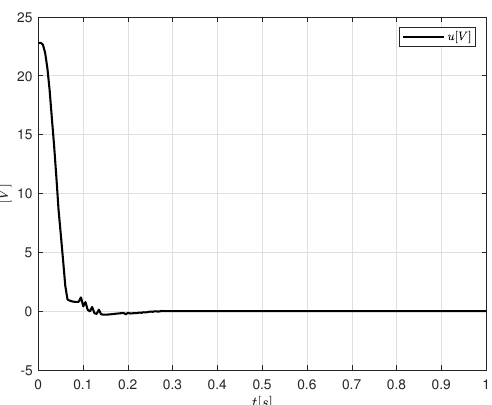
Figure 10. Control signal generated by PID-like FCL implementation.